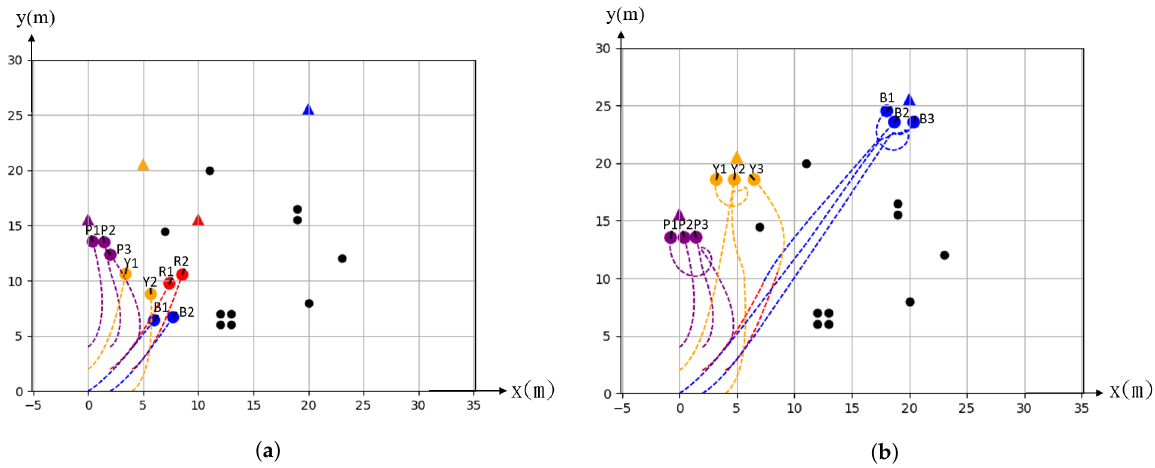
Figure 8. Simulation of decreasing target. ( a ) Original toward to the target. ( b ) Finally stop at each the target.